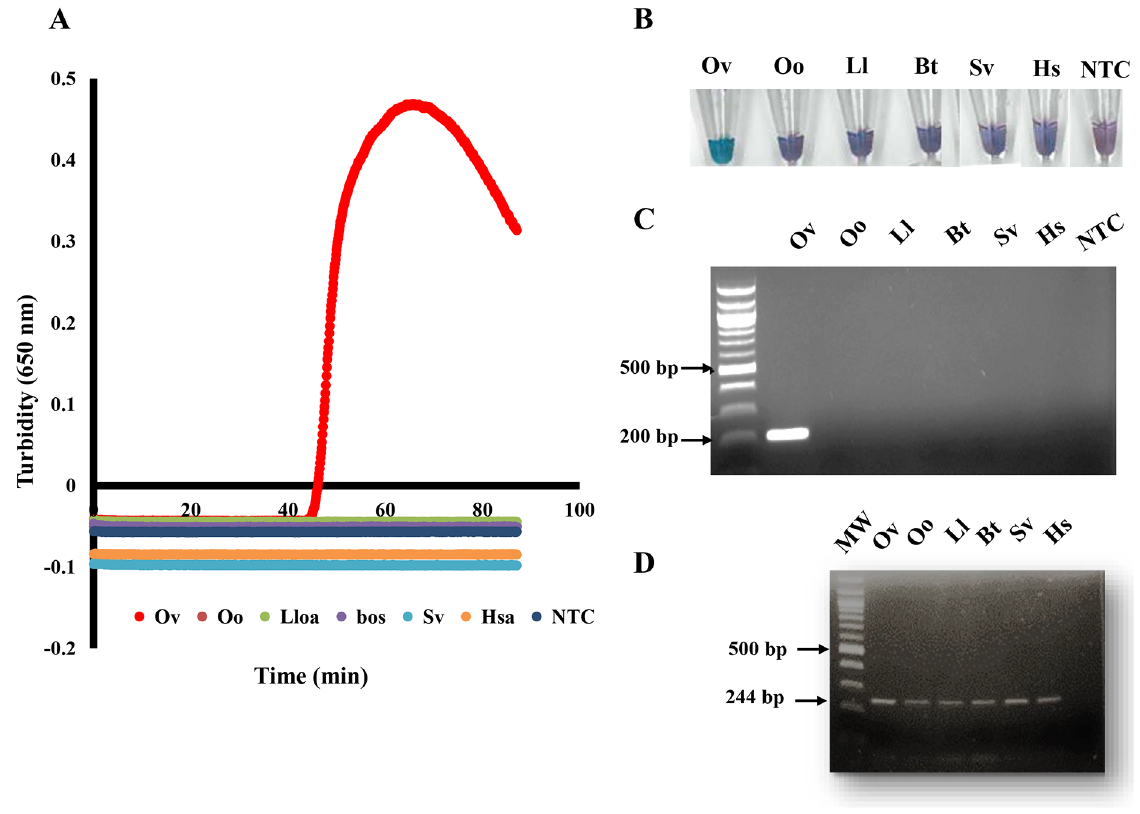
Figure 4. Species-specific LAMP assay targeting OvGST1a . Genomic DNAs from O. volvulus (Ov), O. ochengi (Oo), L. loa (Lloa), Bos taurus (Bos), Simulium vitattum (Sv) and Homo sapiens (Hsa) were used as template in the LAMP assay. Detection using turbidity ( A ). Each curve represents the calculated average of triplicate turbidity curves generated with various genomic DNAs (1 ng) using Bst 2.0 DNA polymerase. Turbidity was observed only using O. volvulus genomic DNA as template. Detection using hydroxy naphthol blue ( B ). Genomic DNAs from O. volvulus (Ov), O. ochengi (Oo), L. loa (Ll), Bovine (Bt), Simulium vitattum (Sv) and human (Hs) were used as template in a PCR assay ( C ). Amplification product ( , 200 bp) using LAMP primers F3 and B3 was obtained when O. volvulus genomic DNA was used (indicated by arrow). As a positive control, an actin gene fragment was PCR amplified from (Ov), (Oo), (Ll), (Bt), (Sv) and Hs DNAs using degenerate primers ( D ). Agarose gel showing amplification of a 244 bp fragment of the actin gene. Water was used in a non-template control (NTC) in all experiments. Molecular weight marker (MW) is